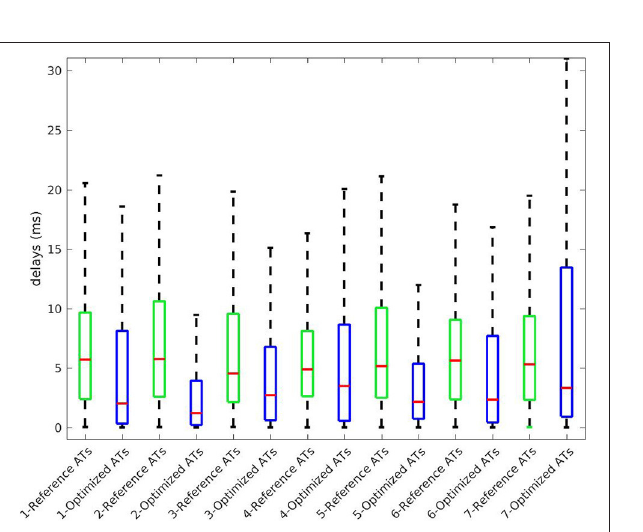
FIGURE 7 | Correlation coefficient of the BSPM, RV pacing case. over time. We observed the same behavior for the RMSE in all the cases. The lower averaged CC in case 7 with Mesh2 was due to a shorter total activation time: late ATs were not well reconstructed. A statistical T -test was performed on the CC for ATs, RTs, and BSPM. The resulting p -values were 0.5, 0.41, and